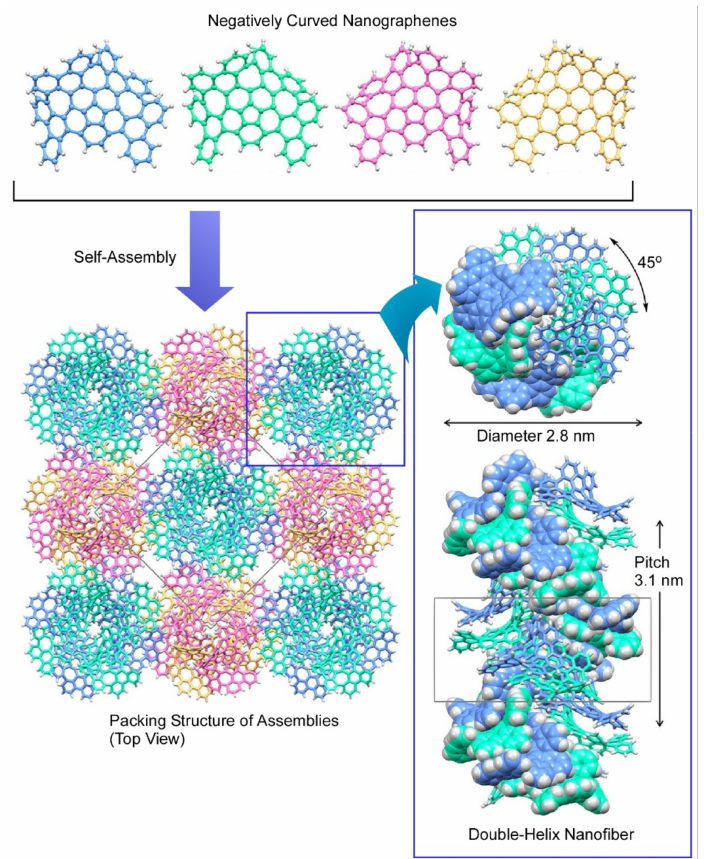
Figure 3. Formation of supramolecular double-helix nanofibers upon self-assembly of negatively curved nanographene. Reprinted with permission from Reference [76]. Copyright 2021 American Chemical